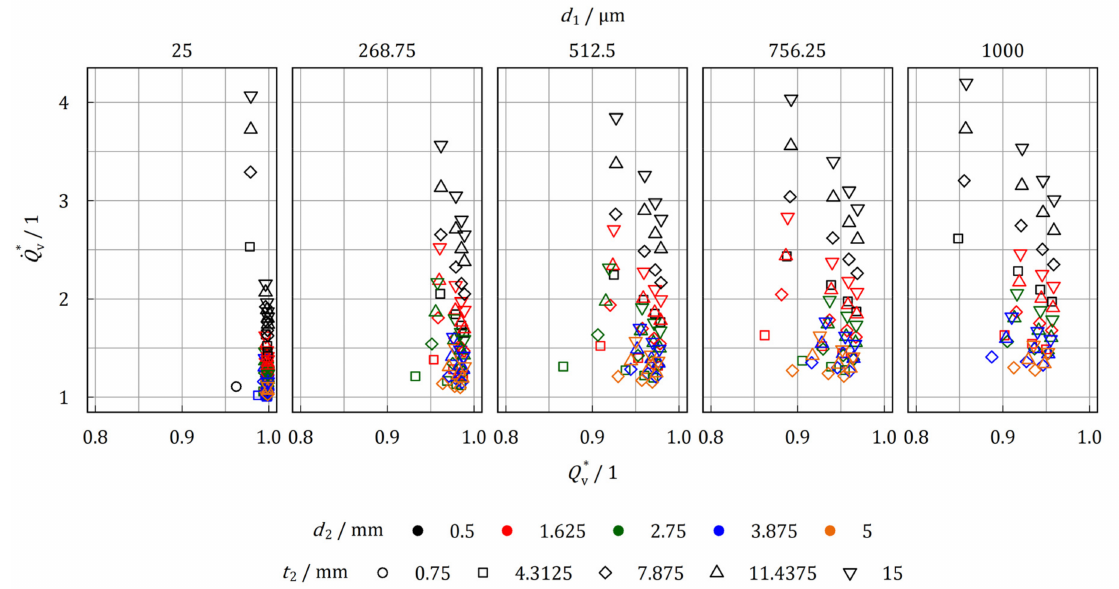
Figure 21. Ratio of mean volume specific power vs. ratio of volume specific storage capacity for all variations of the wire cloth heat exchanger in dependency of wire diameter d 1 , tube diameter d 2 and the tube distance t 2 for aluminum as